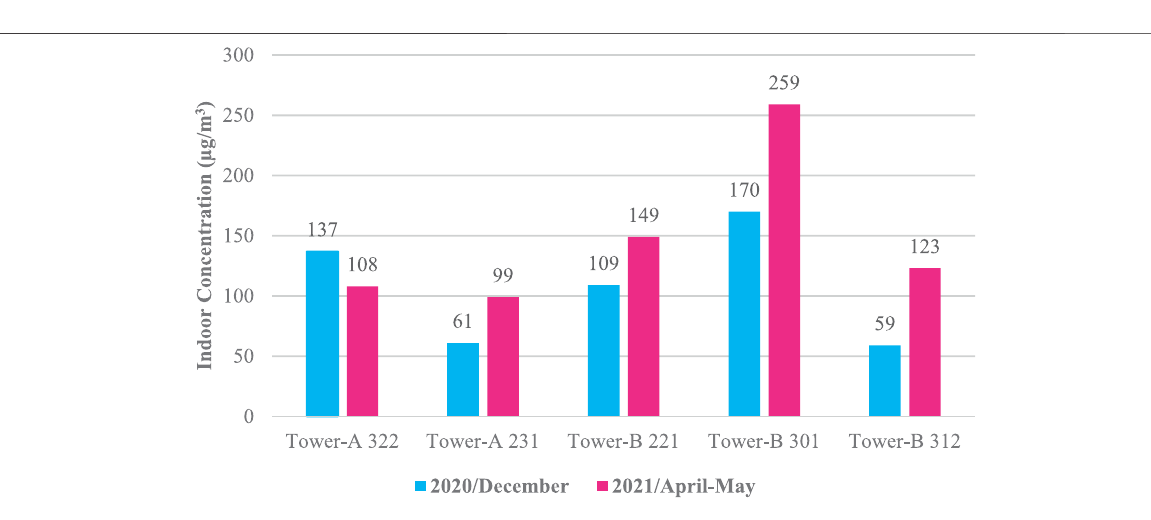
FIGURE 14 | Changes in indoor concentration of CH 2 O by residential unit.